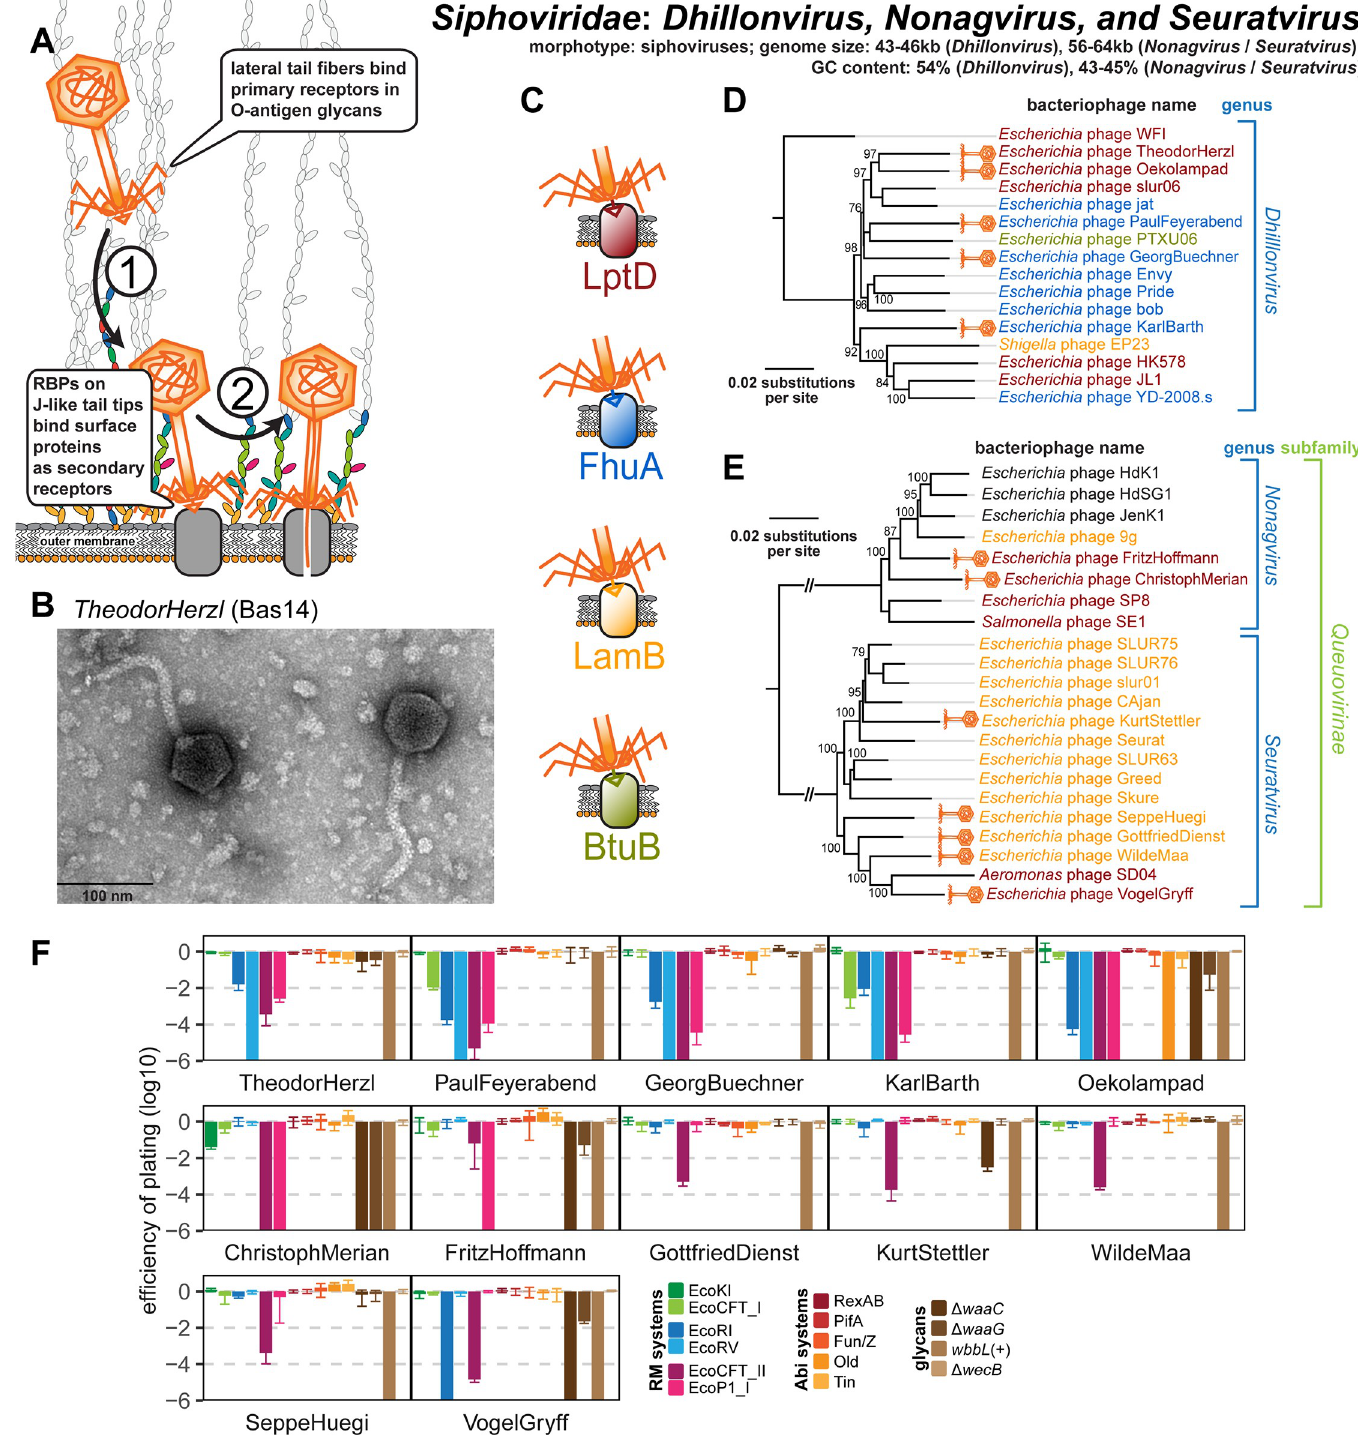
Fig 5. Overview of Siphoviridae genera Dhillonvirus , Nonagvirus , and Seuratvirus . (A) Schematic illustration of host recognition by small siphoviruses. (B) Representative TEM micrograph of phage TheodorHerzl (Bas14). (C) Color code of terminal receptor specificity (same as in Figs 3 and 4). (D) Maximum-Likelihood phylogeny of the Dhillonvirus genus based on a whole-genome alignment with bootstrap support of branches shown if > 70/100. Newly isolated phages of the BASEL collection are highlighted by orange phage icons and the determined or proposed terminal receptor specificity is highlighted at the phage names using the color code highlighted in (C). The phylogeny was rooted between phage WFI and all others based on a representative phylogeny including Drexlerviridae sequences as outgroup